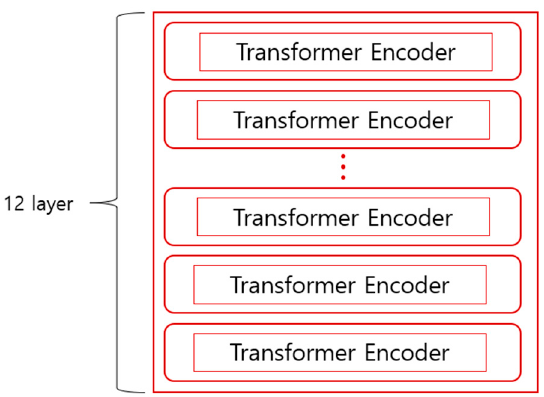
Figure 2. Structure of BERT.